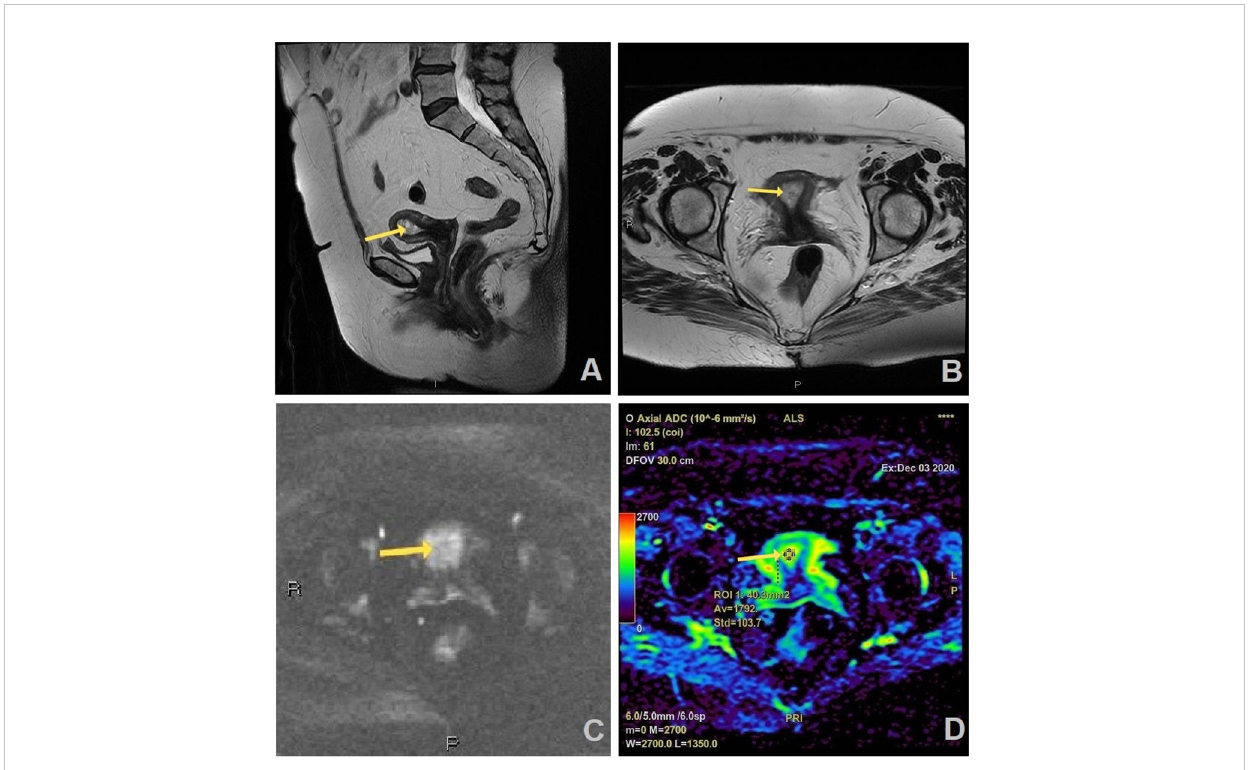
FIGURE 3 MR images of a 66-year old woman with a history of vaginal bleeding, suspicious benign lesion on MRI, and histopathologically proven endometrial hyperplasia: (A) sagittal and (B) axial T2W FR FSE image shows thickened endometrium in uterine cavity (arrow) which is slightly hyperintense on axial DWI (b=1200 s/mm 2 ) (C) and has no correlation on ADC map with the measured ADC value of 1.792 × 10 − 3 mm 2 /s (D) .